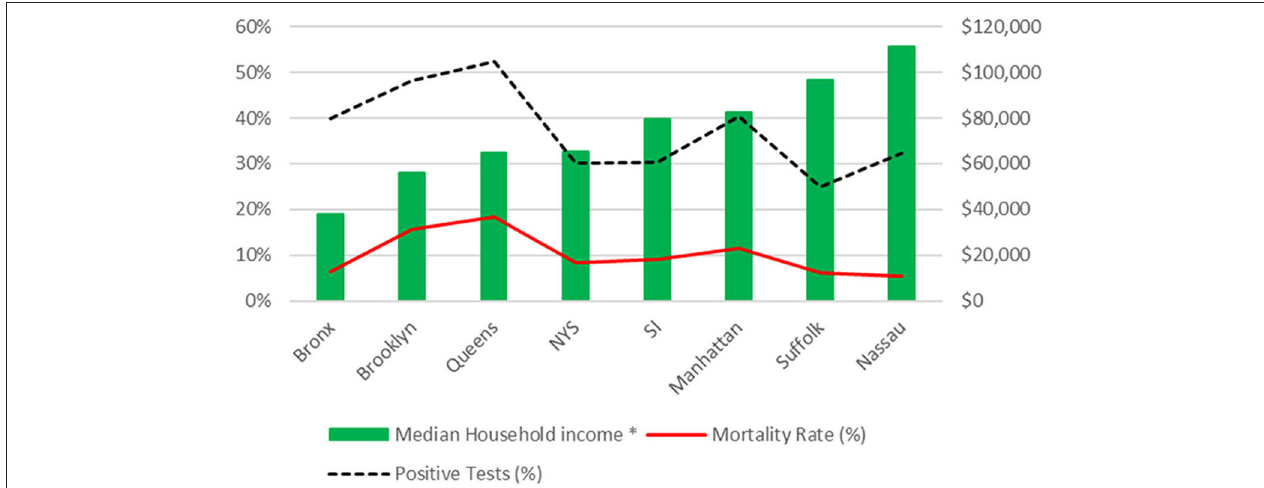
FIGURE 1 | Test positivity rate (%) and mortality rate (%) from this cohort plotted vs. median household income by Zip Code. SI, Staten Island; NYS, New York State. *Median household income data as per 2018U.S Census